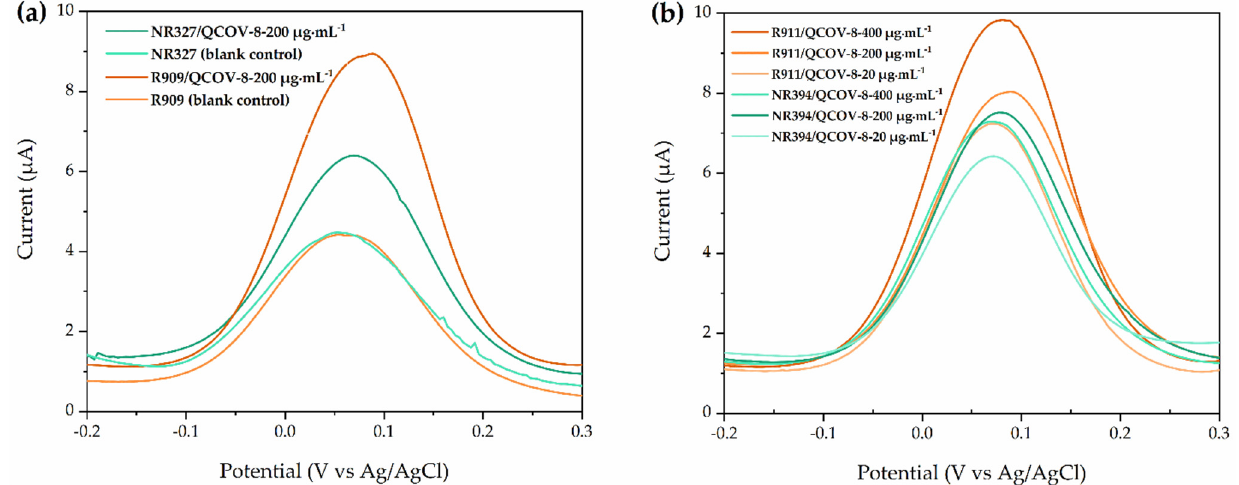
Figure 6. DPV measurements in potassium ferricyanide probe (K 3 [Fe (CN) 6 ]). ( a ) Tests in reactive and non-reactive clinical samples containing 10 µL of a 200 µg·mL − 1 of antigen solution. ( b ) DPV measurements of immunosensors containing 10 µL of 100, 200 and 400 µg·mL − 1 of antigen solution, where R represents reactive clinical samples and NR represents non-reactive clinical samples. Table 1. Summary of all relevant data from reactive and non-reactive clinical samples of human blood serum for COVID-19 according to ELISA tests, qRT-PCR and our electrochemical biosensor.